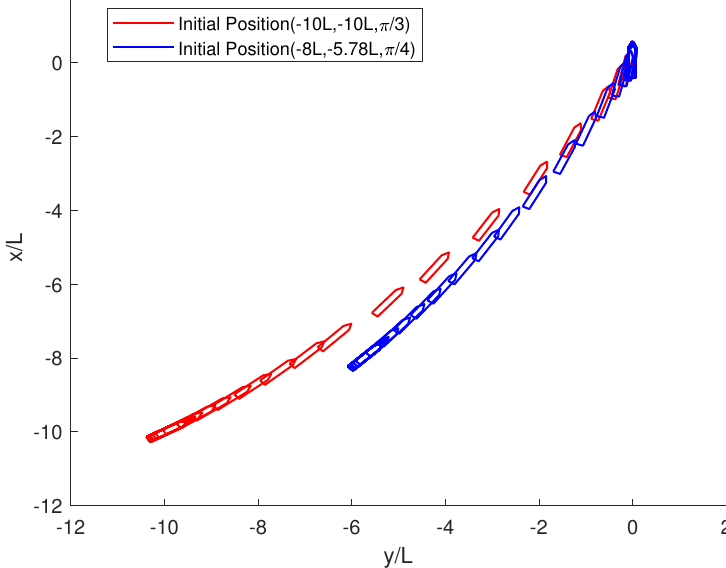
Figure 6. Berthing path of control scheme Equation (49) with different initial